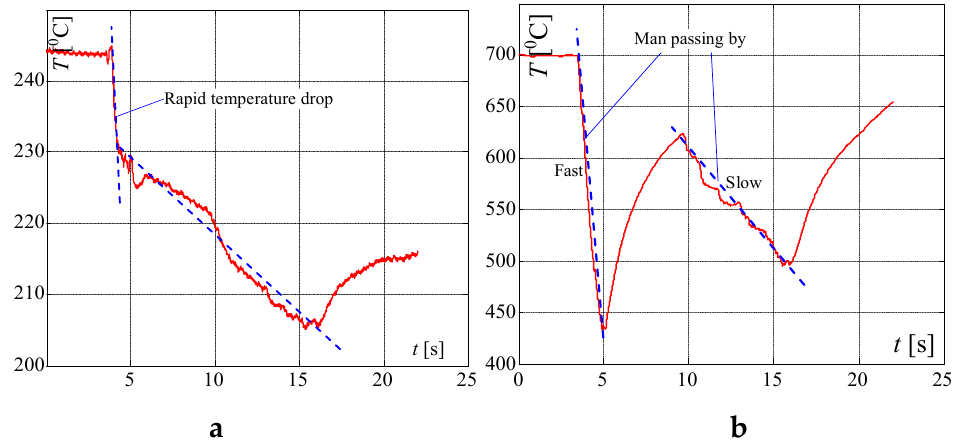
Figure 6. Temperature changes during non-controlled air blow caused by: ( a ) opening the window when the flame is small; ( b ) quick and slow human movement when the flame is big.